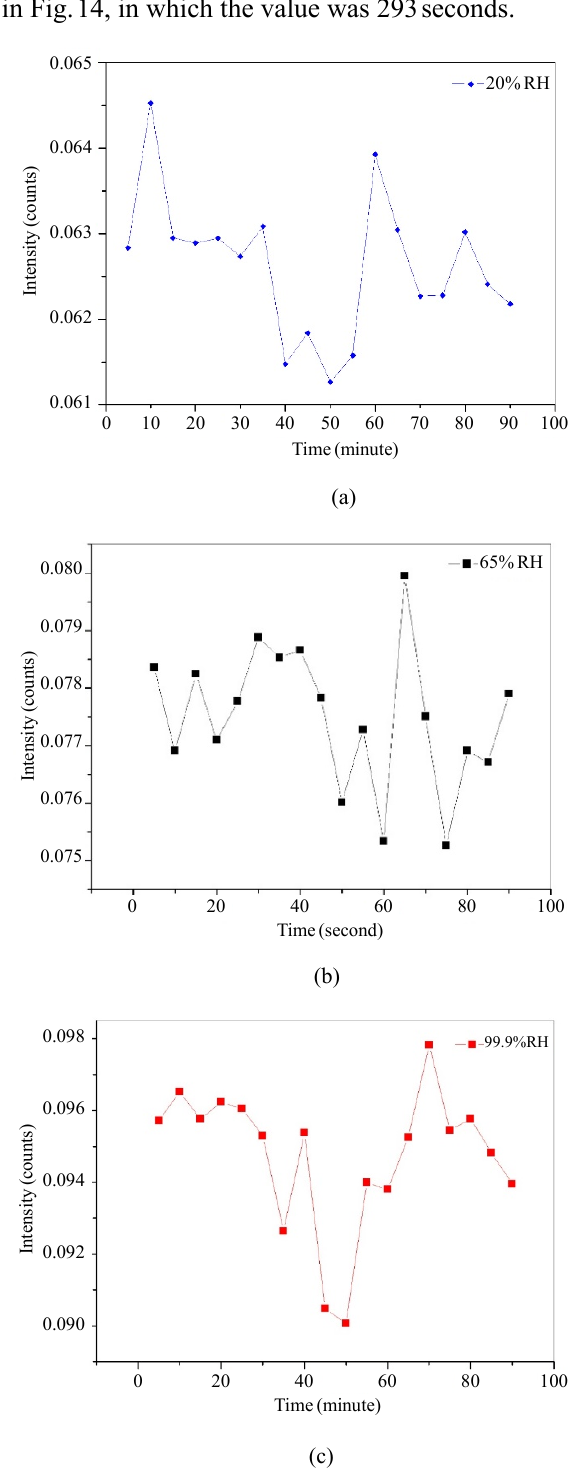
Fig. 12 Fluctuation of stability data at (a) 20% RH, (b) 65% RH, and (c) 99.9%